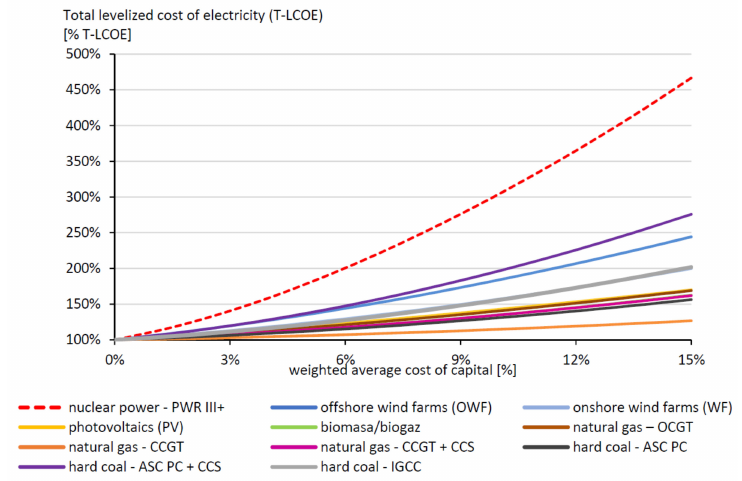
Figure 4. The dependence between the lower cost of capital and the price of electricity from nuclear power plants. Estimation the sensitivity of the total levelised cost of electricity (T-LCOE) in 2035. Variable: weighted average cost of capital (WACC). Constant: 30% penetration of the given variable RES technology the system.